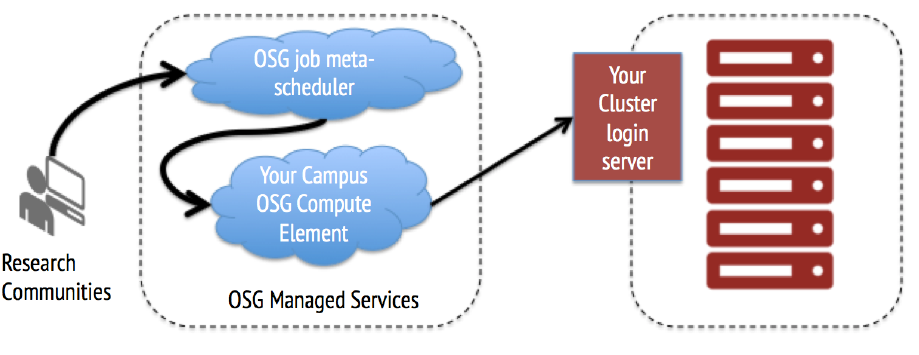
Figure 1. Interaction between di ff erent OSG services and site